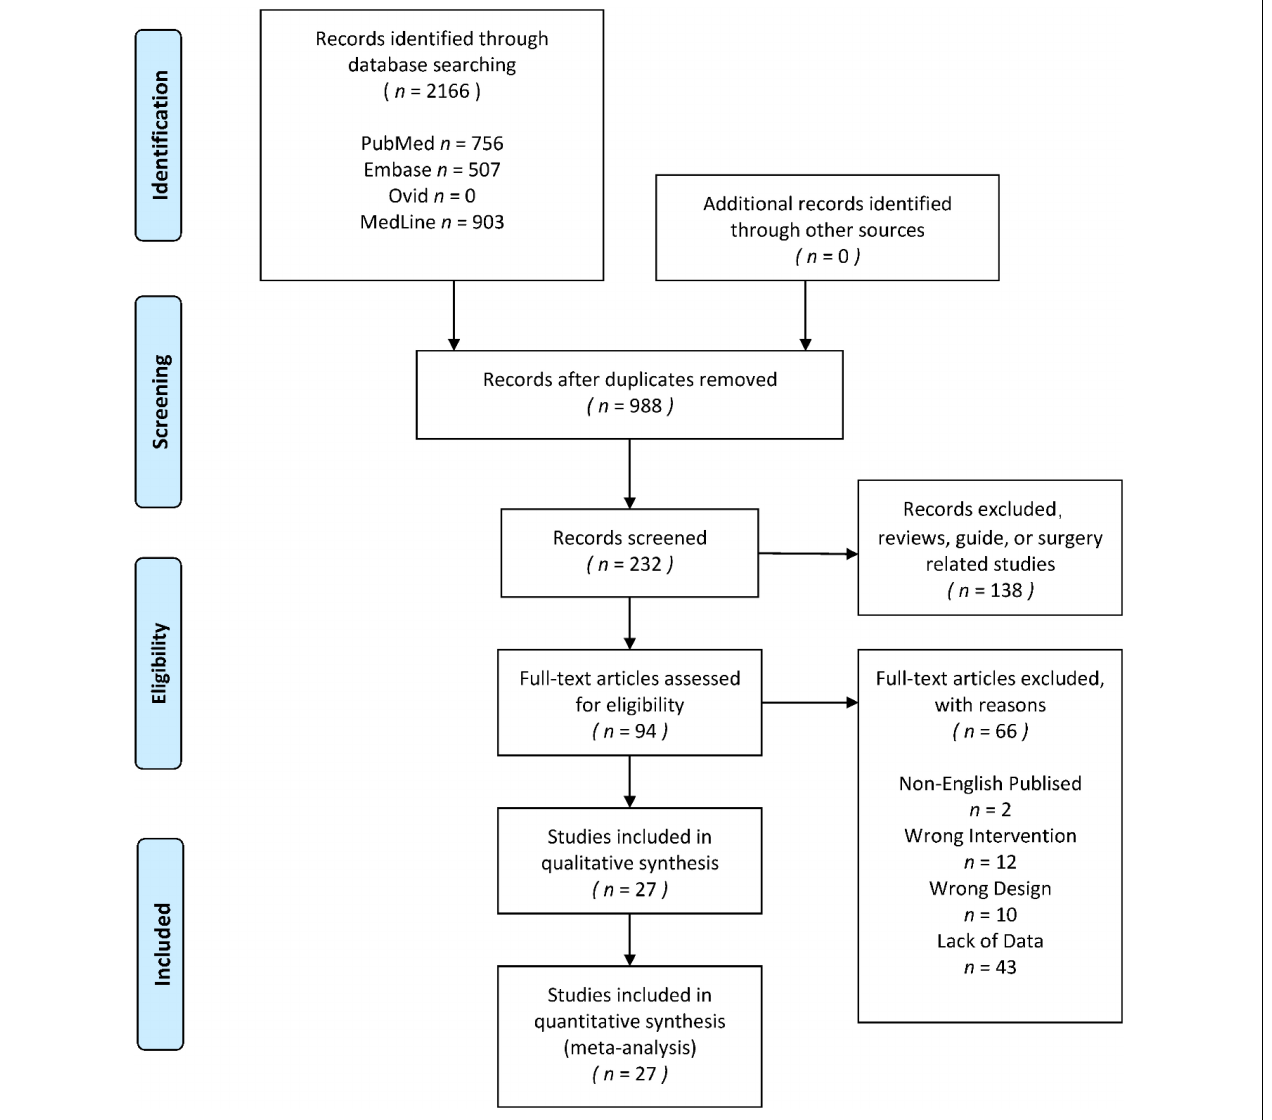
FIGURE 1 | Preferred Reporting Items for Systematic Reviews and Meta-Analysis guidelines (PRISMA) flow diagram for the systematic review and network meta-analysis.